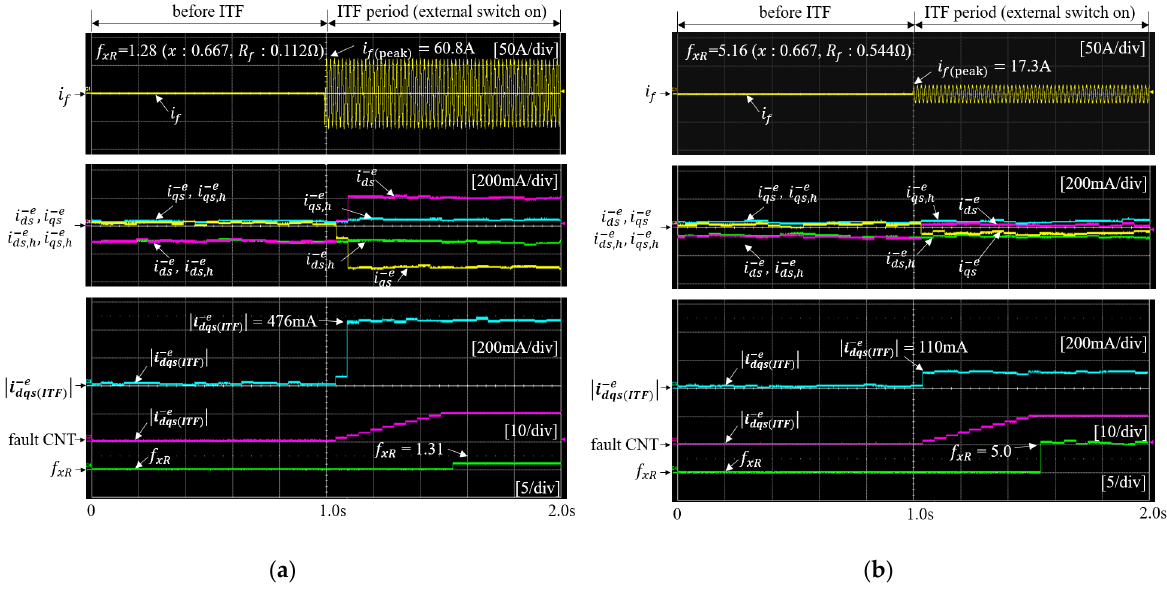
Figure 10. Experimental results of the proposed ITF diagnosis and 𝑓 (cid:3051)(cid:3019) estimation method, ( a ) 𝑓 (cid:3051)(cid:3019) = 1.28 ( 𝑥 : 0.667, 𝑅 (cid:3033) : 0.112 Ω ), and ( b ) 𝑓 (cid:3051)(cid:3019) = 5.16 ( 𝑥 : 0.667, 𝑅 (cid:3033) : 0.544 Ω